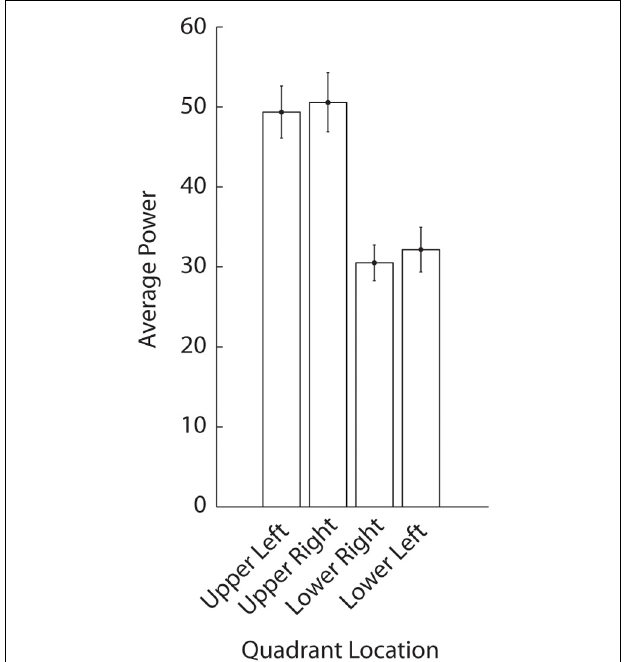
FIGURE A2 | Average pupil oscillation power per quadrant location in Experiment 2. The flickering quadrant in the upper visual field induced the strongest pupillary responses.